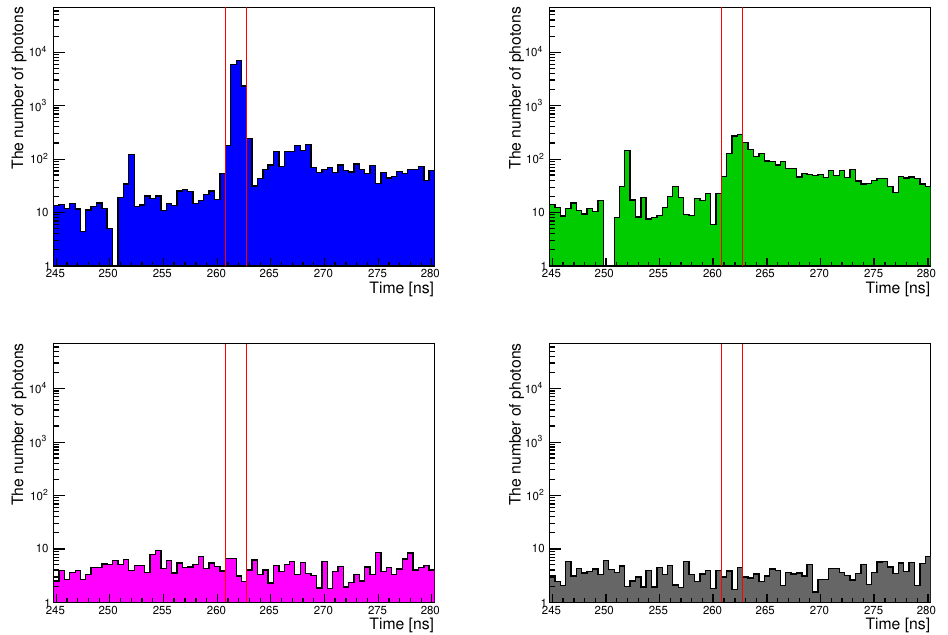
Figure 7 . Arrival-time distributions of observed photons in individual beam combinations at 4 . 32 × 10 − 5 Pa . The red lines represent a time window within which signal photons are expected to arrive. The upper-left, upper-right, lower-left, and lower-right histograms correspond to the S, C, I, and P beam combinations,